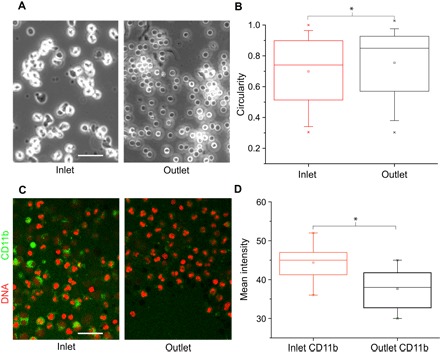
Depolarization in the MMM: shape change and molecular readouts.(A) Chemically primed neutrophils at the inlet showing pseudopods, round up in the outlet within 5 min following advection through constrictions. Images are representative of n = 5 experiments at 50-mbar driving pressure with MMM minimum gaps of 5 μm. (B) Box plot showing the quantification of shape changes (A), with a significant (P < 0.05) increase in circularity following stenotic advection for cells in the outlet, compared to cells in the inlet. (C) Confocal images of fMLP-treated CD11b+ neutrophils before (inlet) and 5 min after (outlet) stenotic advection in MMM at 50 mbar (minimum gap of 5 μm). (D) Box plots of CD11b intensity from (C) showing a significant reduction (P < 0.05) in CD11b intensity about 5 min following stenotic advection. Scale bars, 50 μm.